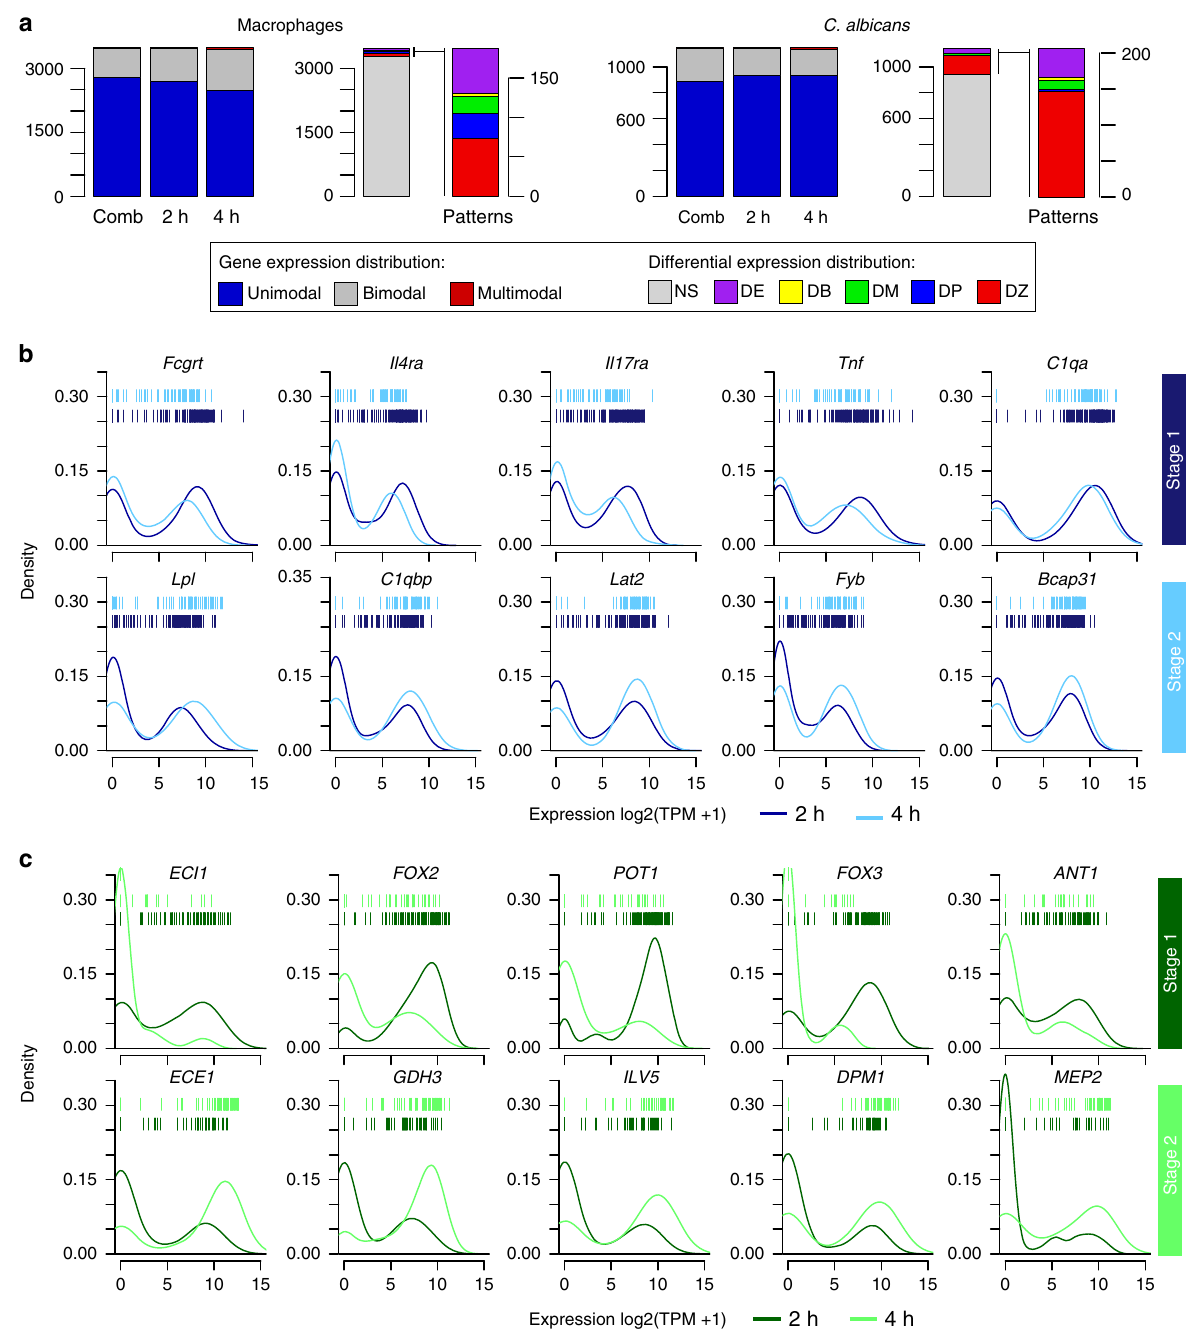
Fig. 5 Expression variability and bimodality at the single-cell level. a Number of genes categorized as unimodal, bimodal, or multimodal (>2 components) according genes expression patterns in single, infected macrophages and corresponding phagocytized C. albicans across cells from 2 and 4 h, and within each time point. Differential distributions were assigned as differential expression of unimodal genes (DE), differential modality and different component means (DB), differential modality (DM), differential proportion for bimodal genes (DP), differential proportion of zeroes (DZ), and not signi fi cant (NS). b Expression density distributions in parallel infected macrophages ( n = 267; blue) and c phagocytized live C. albicans ( n = 215; green) for 5 top marker genes in co-state1 and co-state2 across macrophages – C. albicans single cells at 2 and 4 h postinfection. Individual cells are plotted as bars for 2 h (top row) and 4 h (bottom row) for each